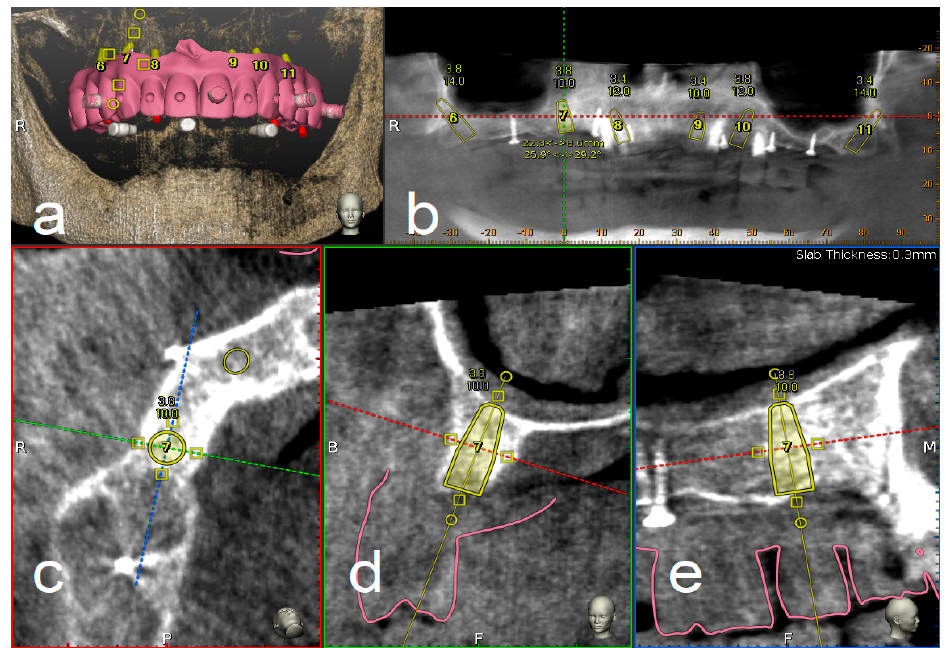
Figure 1. Implant planning using stereolithography (STL) files as reference for a prosthetic driven implantation ( a ). Panoramic ( b ), axial ( c ), bucco-lingual ( d ), and parasagittal ( e ) view.